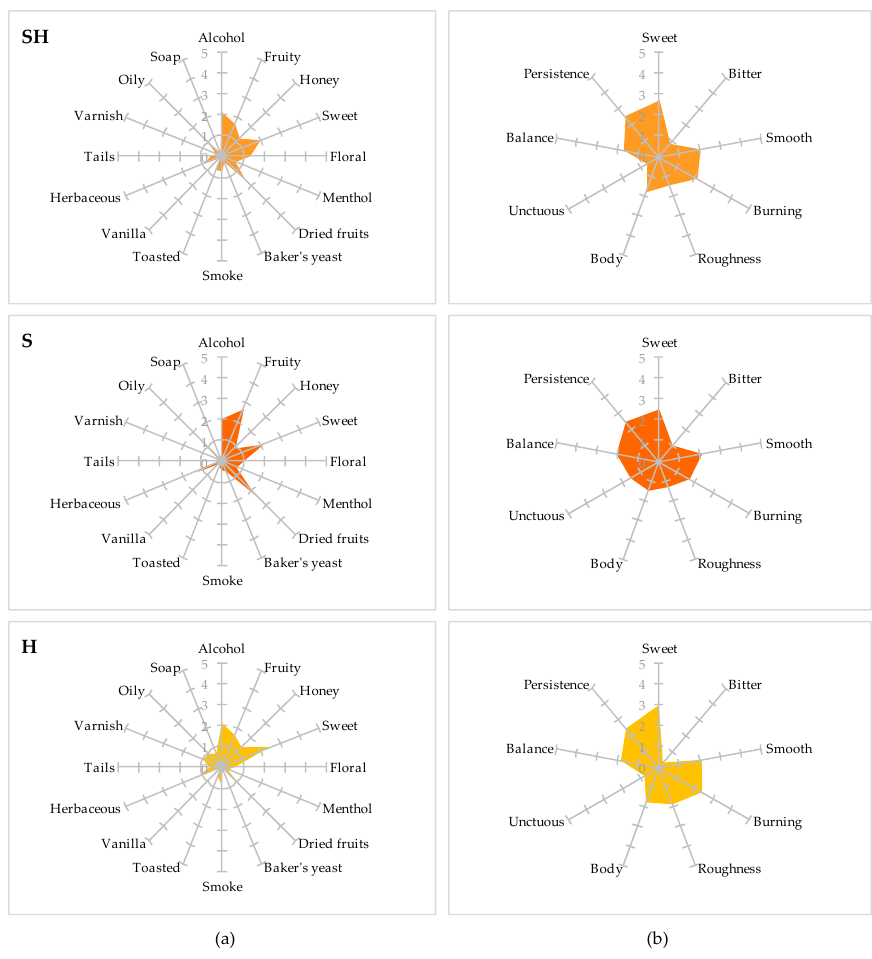
Figure 2. Aroma ( a ) and flavor ( b ) profiles based on the average panel attributes’ scores of the spirit drinks (SH, new spirit drink made with strawberry tree fruit and honey; S, arbutus spirit; H, honey spirit).